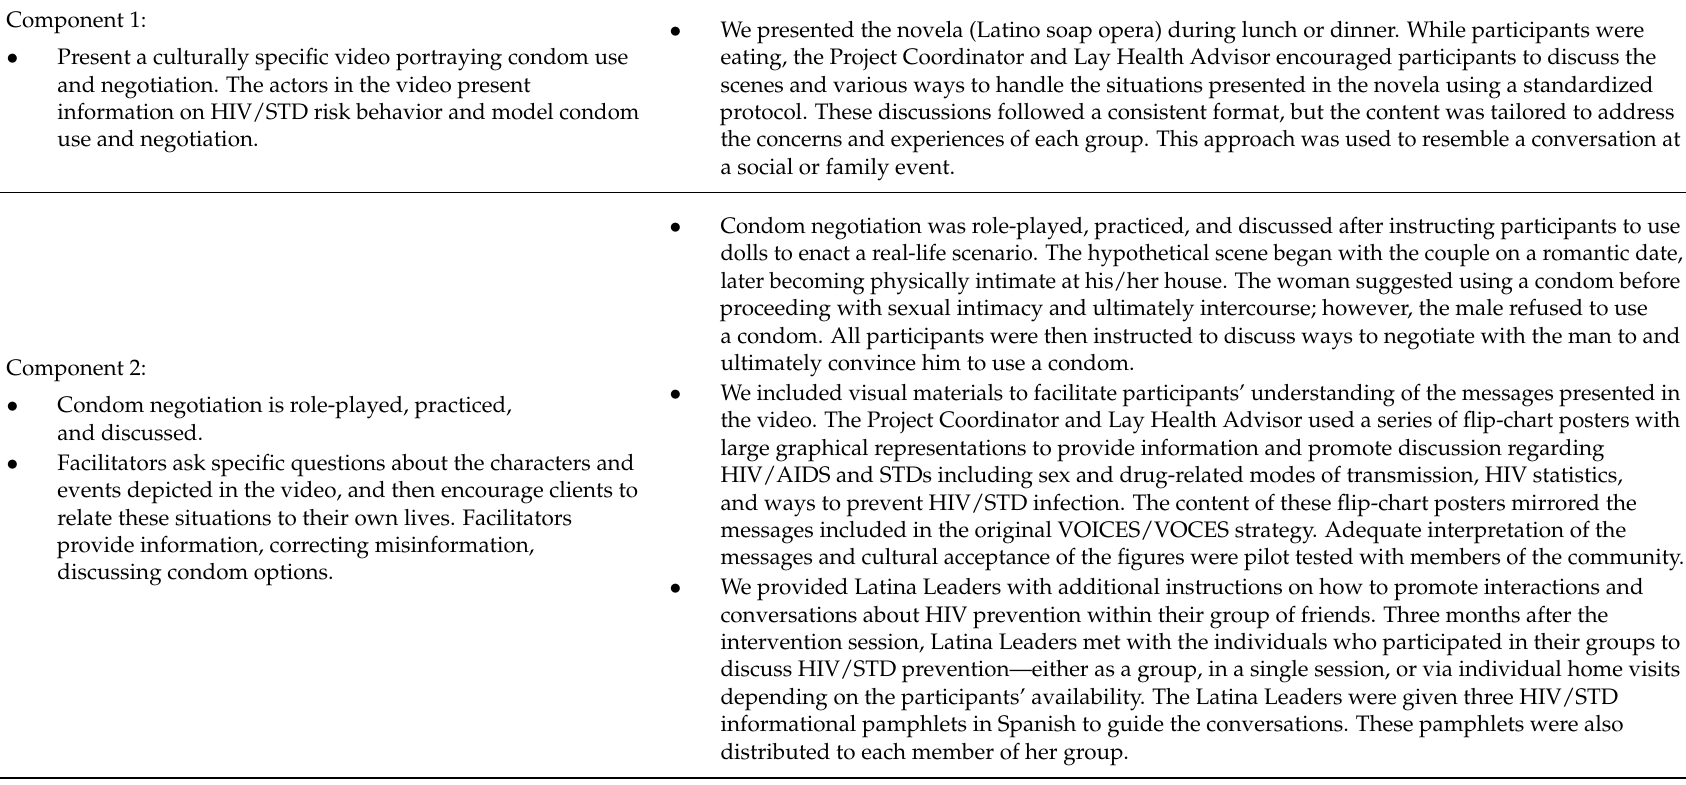
Table 2. Original Core Components of VOICES/VOCES and Adapted Core Components of Progreso en